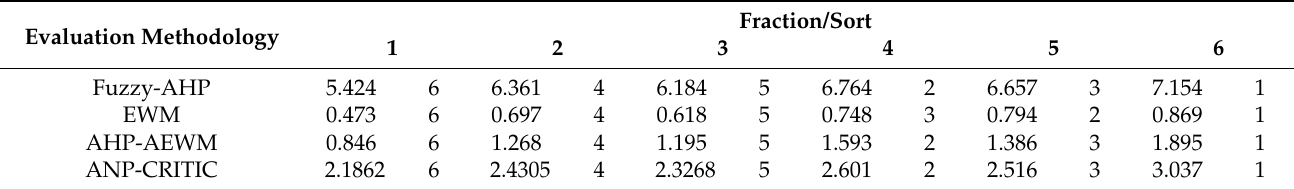
Table 7. Results and rankings under different